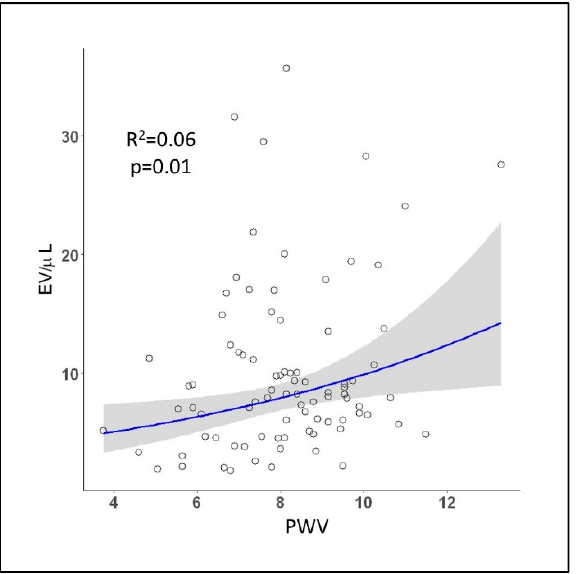
Figure 2. Extracellular vesicles and macrovascular damage. Regression model of extracellular vesicles and PWV ( p = 0.01). Blue line represents regression line of best fit. The grey bands around the line represent 95% confidence intervals.